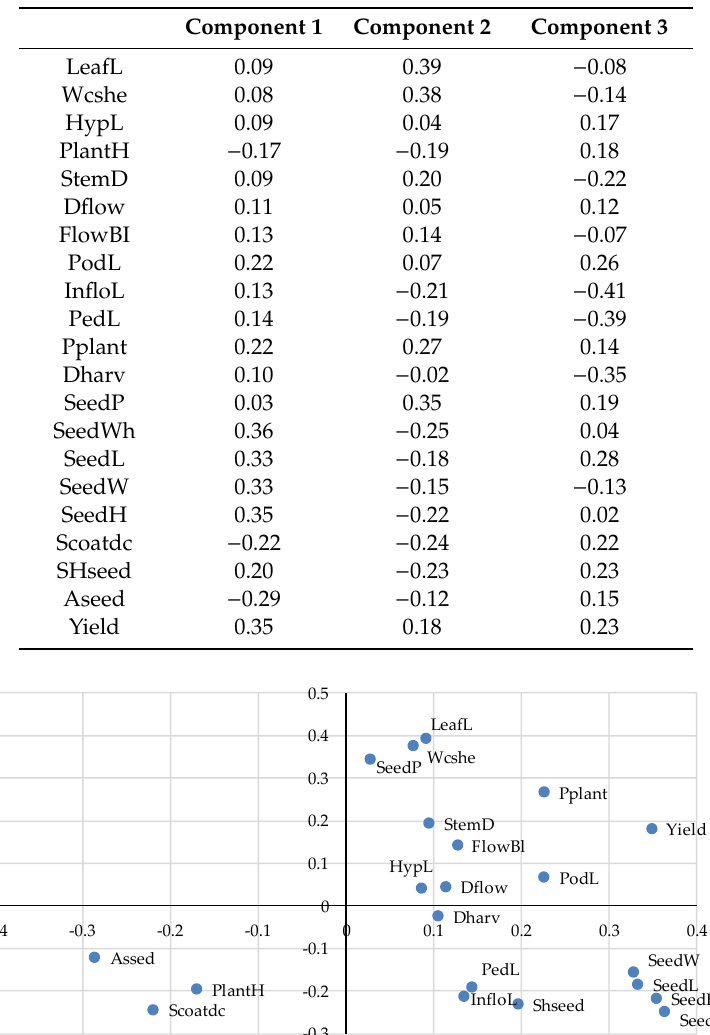
Table 3. Correlation coe ffi cients between the first three principal components (PCs) and the morphological descriptors.